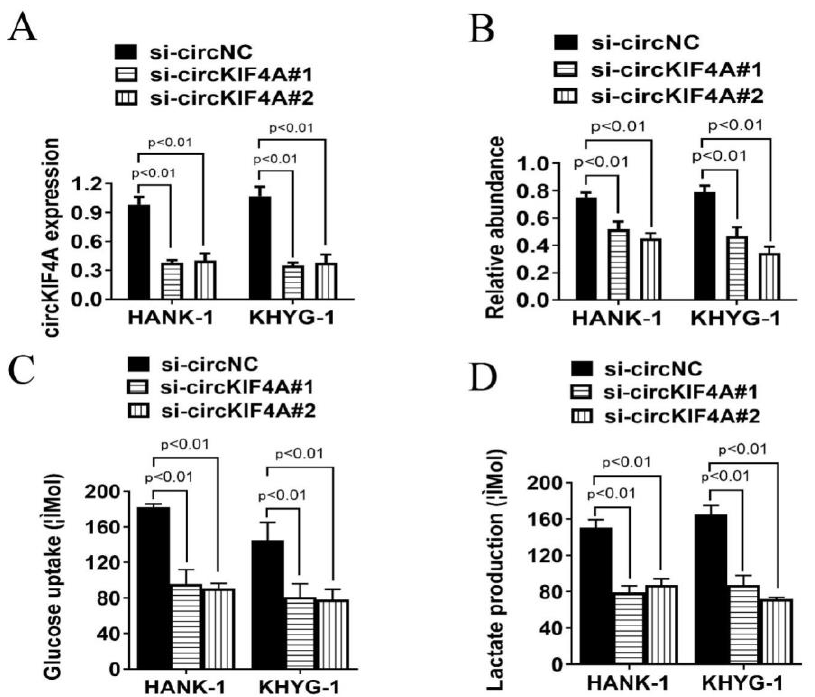
Figure 3. CircKIF4A silencing affected glucose uptake and lactate production in NKTL. ( A , B ) qPCR analysis of siRNA-mediated circKIF4A silencing. ( C ) CircKIF4A silencing associated with decreased glucose uptake levels. ( D ) CircKIF4A silencing correlated with reduced lactate levels. si-circNC, negative control siRNA; si-circKIF4A#1 and si-circKIF4A#2, two siRNAs designed to inhibit circKIF4A